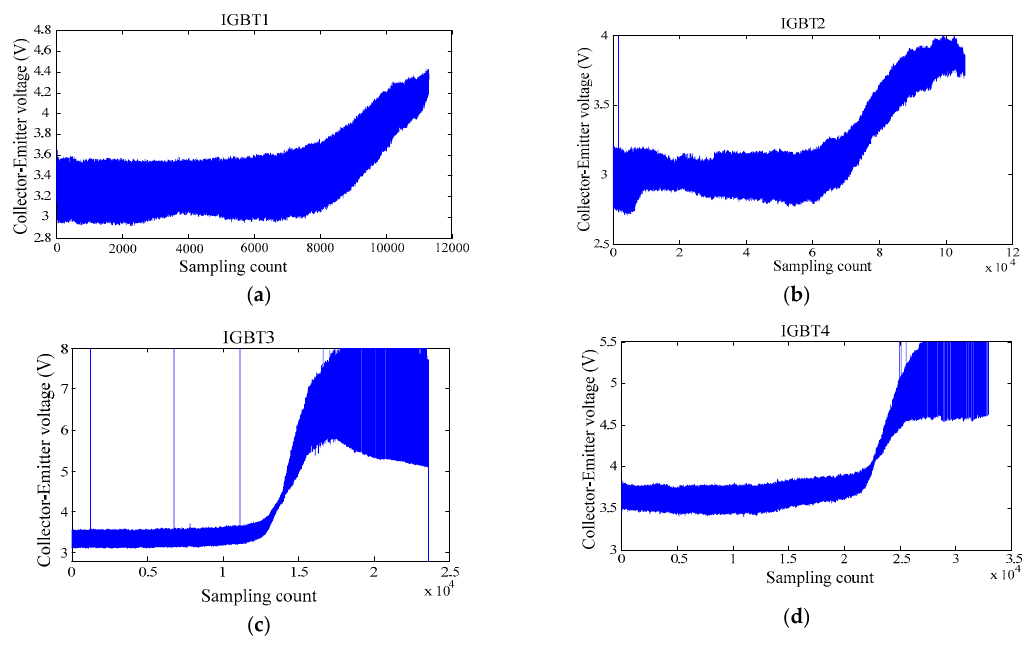
Figure 4. Experimental data. ( a ) IGBT1 expermental raw data; ( b ) IGBT2 expermental raw data; ( c ) IGBT3 expermental raw data; ( d ) IGBT4 expermental raw data. ( c ) IGBT3 expermental raw data; ( d ) IGBT4 expermental raw